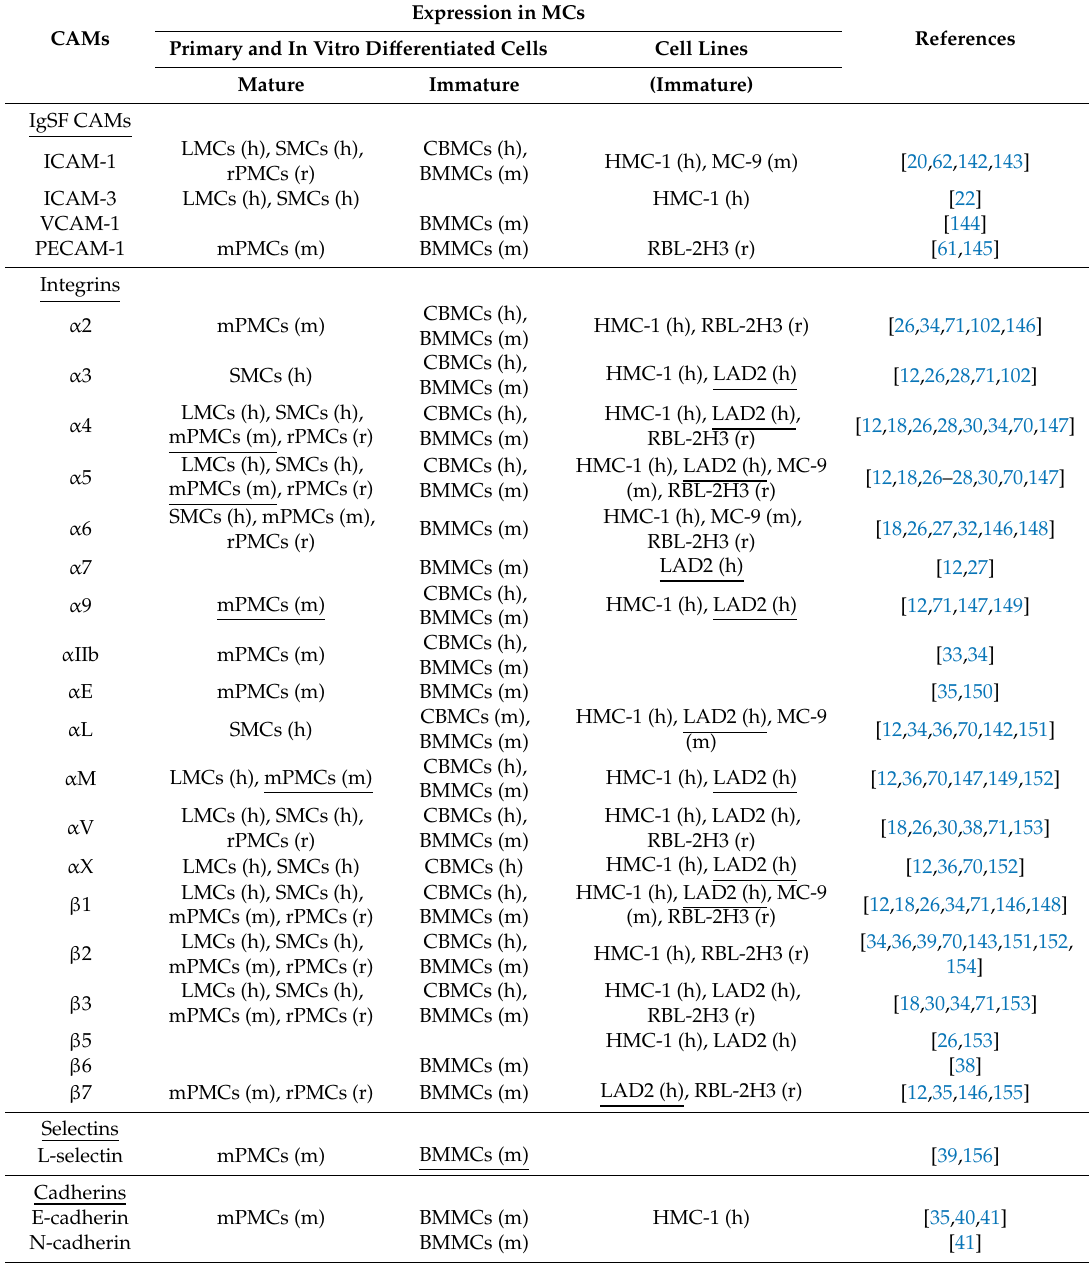
Table 2. Cell adhesion molecule expression in various types of